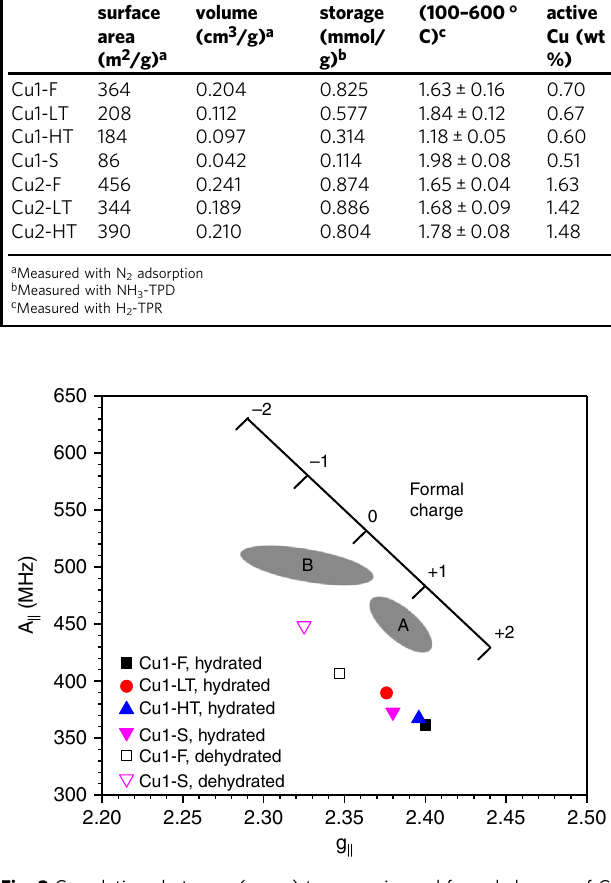
Table 1 Textural properties, chemical titration results, and isolated Cu(II) contents of the catalysts Sample BET